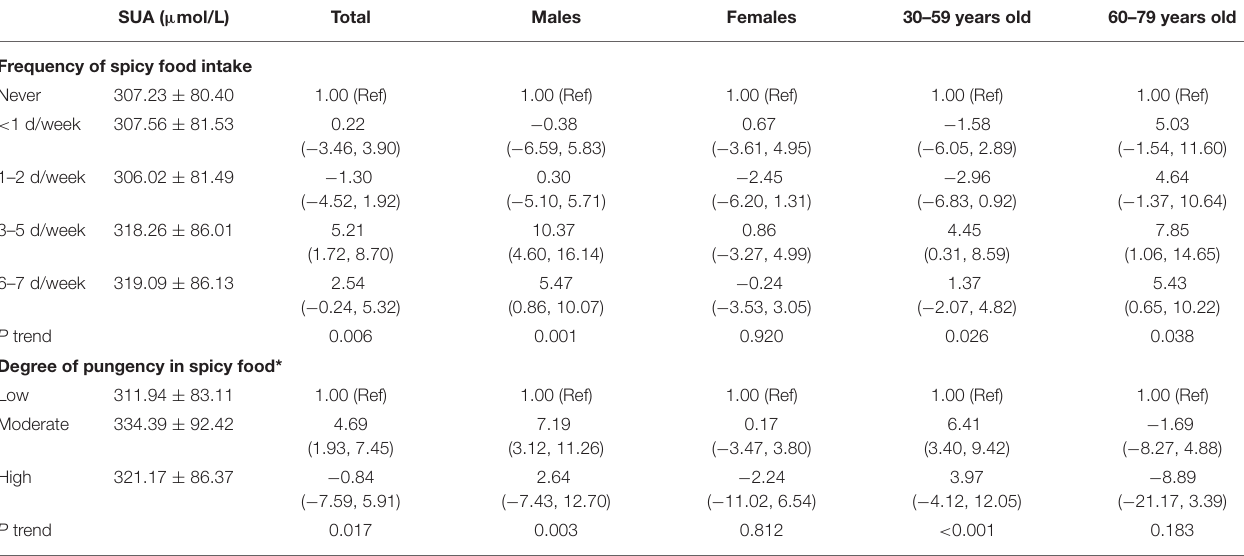
TABLE 4 | Multivariable-adjusted associations ( β coefficients and 95% CI) of frequency and degree of pungency in spicy food with serum urate